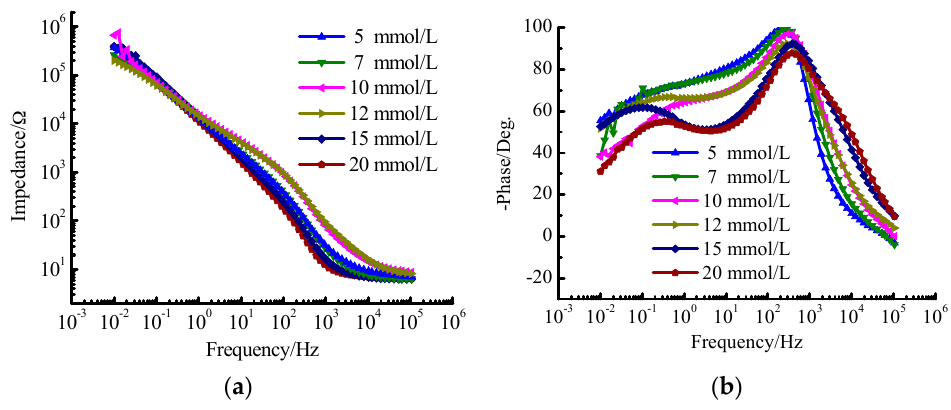
Figure 2. Bode figure for TA2 under different glucose concentrations. ( a ) lg| Z | versus lg f curve; and ( b ) − θ versus lg f curve.